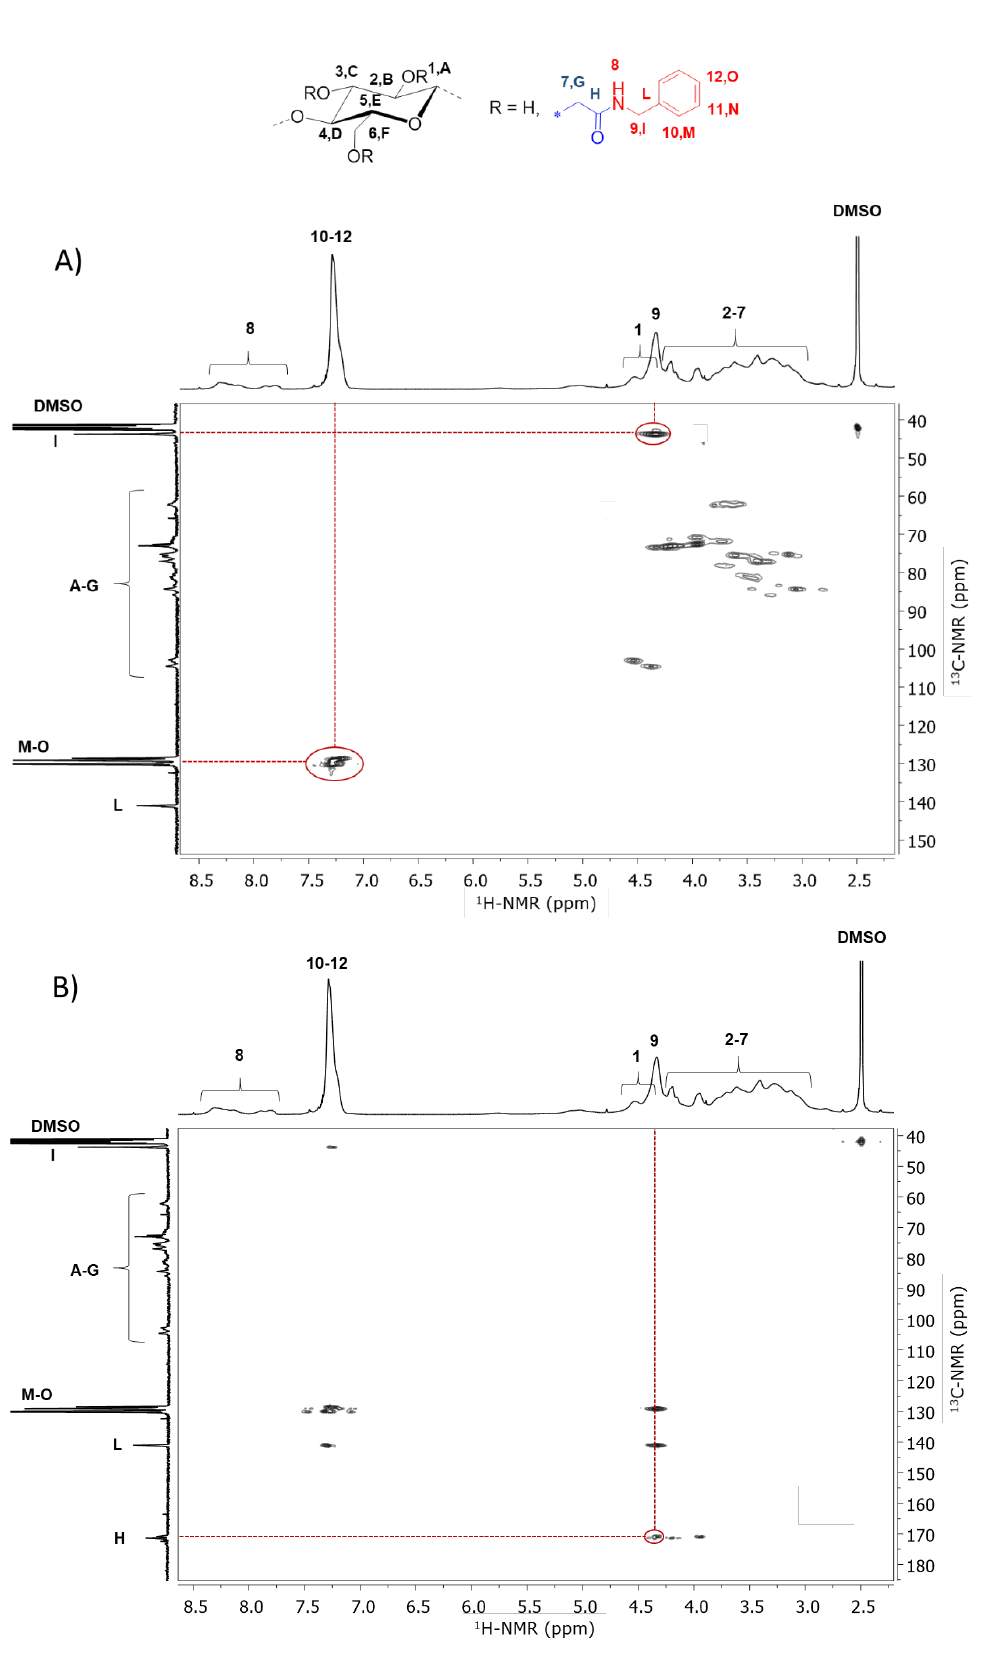
Figure 5. Heteronuclear Single-Quantum Correlation (HSQC) ( A ) and Heteronuclear Single-Quantum Correlation (HMBC) ( B ) spectra of product CMC-Benz (Table 1, Entry 3), in DMSO-d6 and at 358 K.